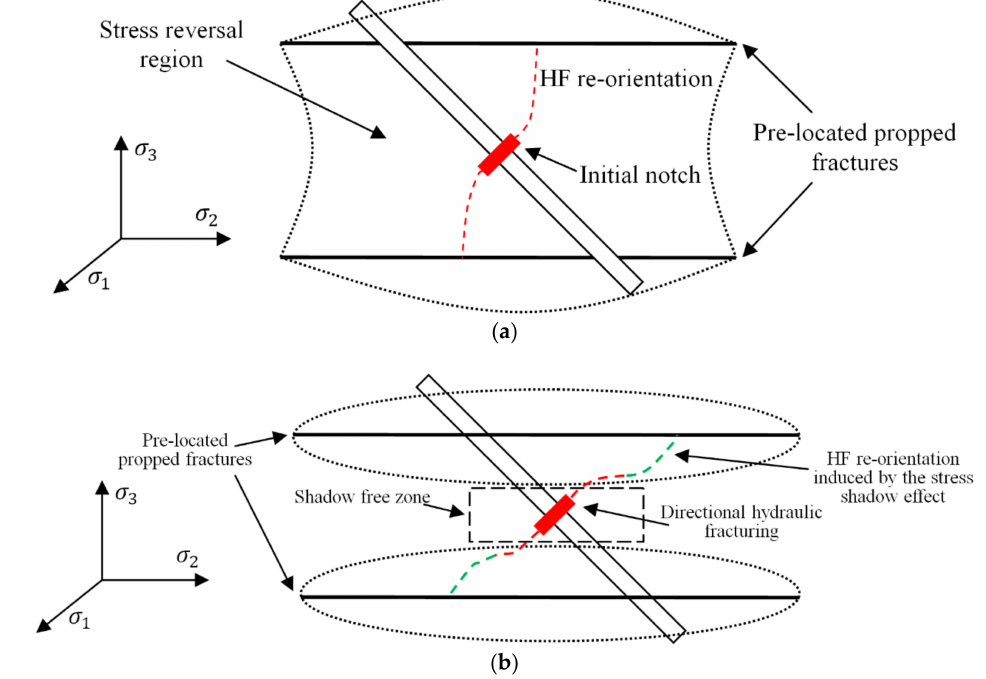
Figure 1. Approaches to creating PHFs [4]: ( a ) Stress shadows of pre-located fractures overlap and create a stress reversal region between them. The PHF initiates from the oriented initial notch and propagates parallel to the in-situ σ 3 orientation; ( b ) Stress shadows of pre-located fractures do not overlap and leave a stress shadow free zone between them. Directional hydraulic fracturing is applied to control the PHF initiation direction, and the stress shadow effect is used to induce the secondary PHF